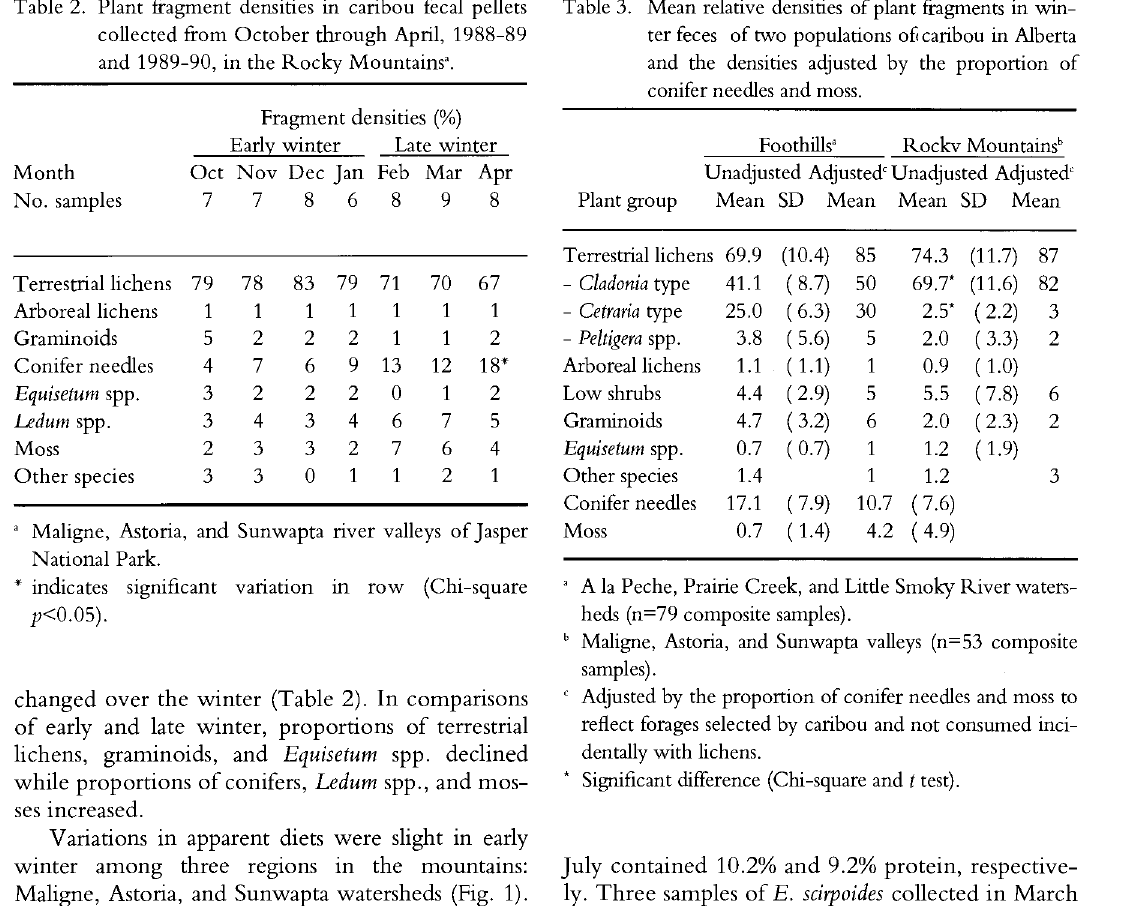
Table 2. Plant fragment densities in caribou fecal pellets Table 3. Mean relative densities of plant fragments in win